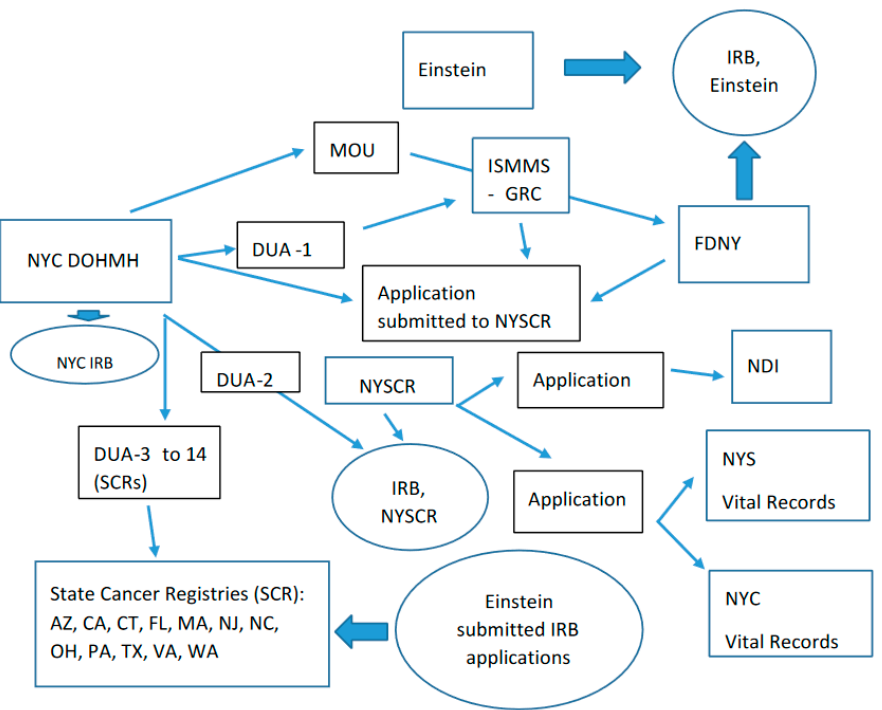
Figure 1. Administrative agreements across study entities. Abbreviations: IRB, Institutional Re-